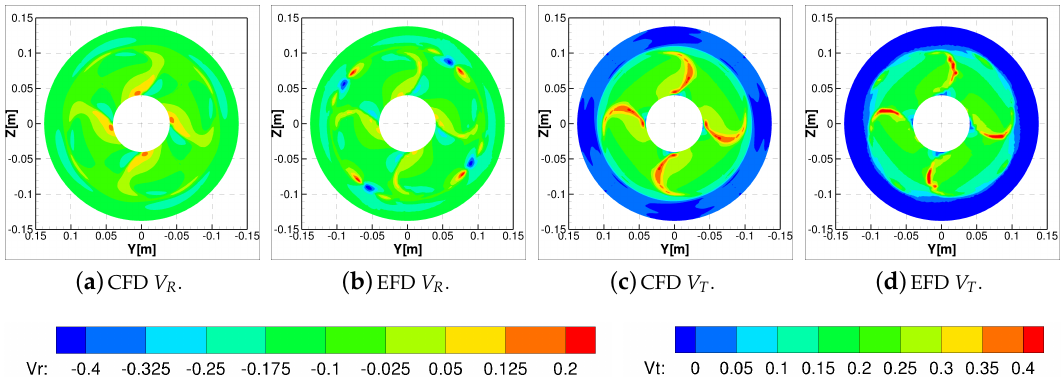
Figure 16. Radial ( V R ) and tangential ( V T ) non-dimensional velocity at 0.3 x/D transversal section with